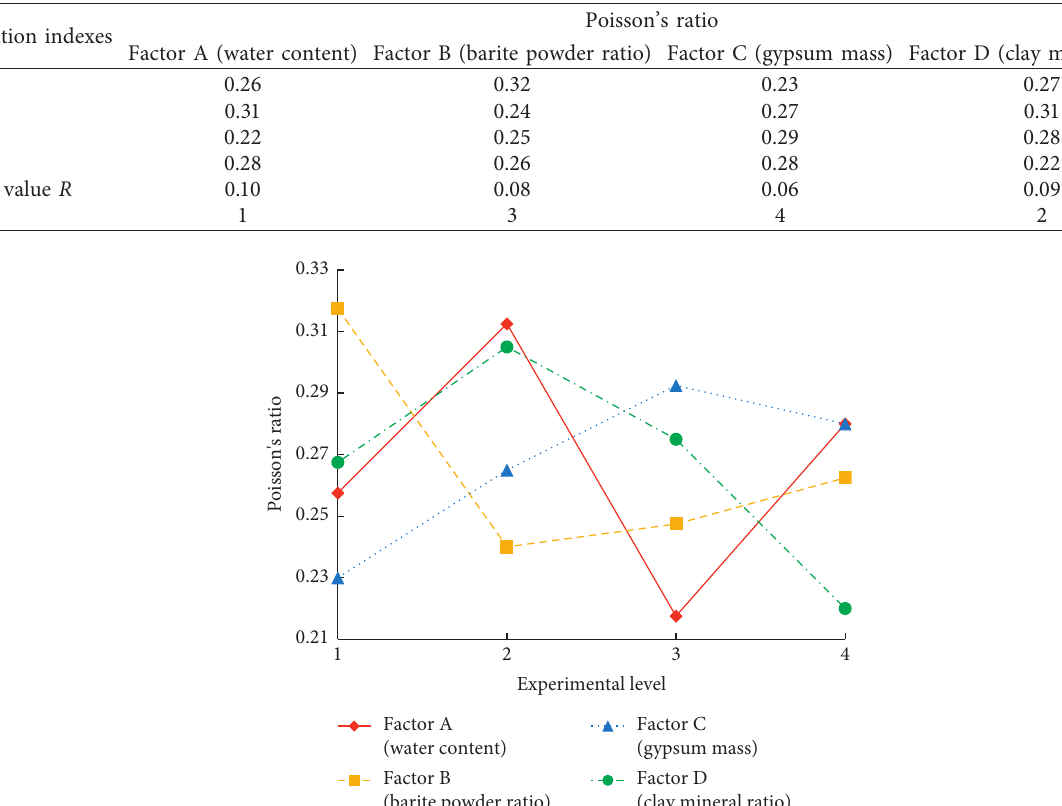
Table 16: Range analysis of Poisson’s ratio.